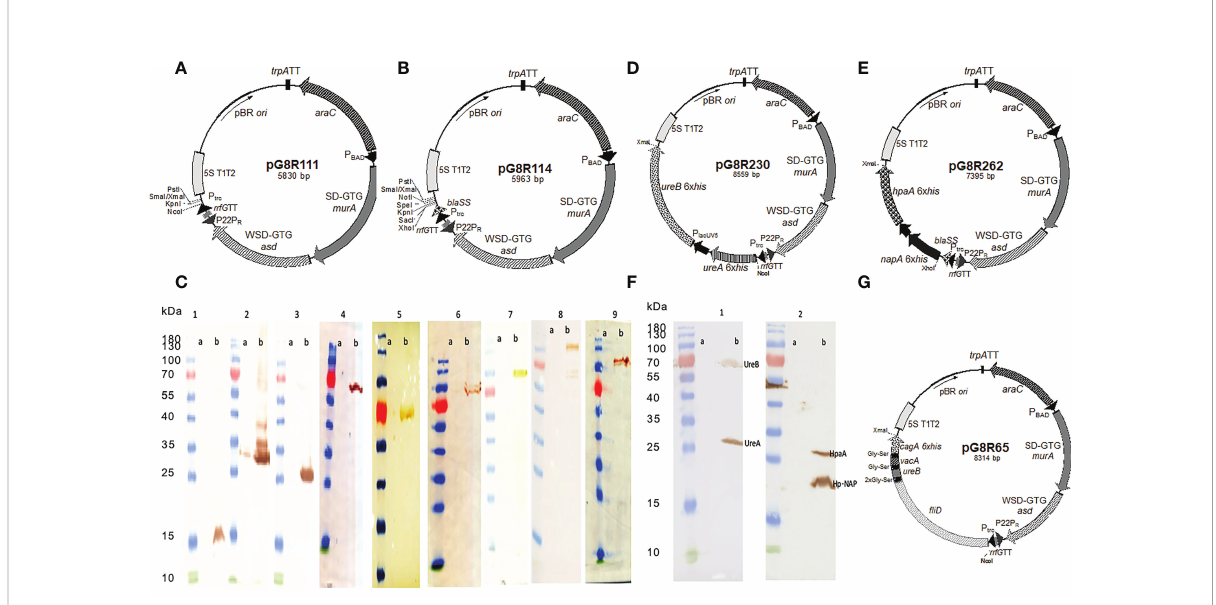
FIGURE 1 Synthesis of ( H ) pylori antigens in S . Typhimurium c 12341. Regulated delayed lysis plasmid vectors pG8R111 (A) and pG8R114 with improved bla SS (B) . (C) Synthesis of nine putative ( H ) pylori antigens in S . Typhimurium c 12341. (1) Hp-NAP (17.7 kDa), (2) HpaA (26.9 kDa), (3) UreA (27.5 kDa), (4) UreB (62.3 kDa), (5) HopM (74.6 kDa), (6) BabA (79.6 kDa), (7) Chimeric Protein (90 kDa), (8) CagA (131.8 kDa), (9) VacA(136.3 kDa). (a) Uninduced with IPTG and (b) 2 h after induction with IPTG compared to molecular mass markers. Anti-6xHis monoclonal antibody was used